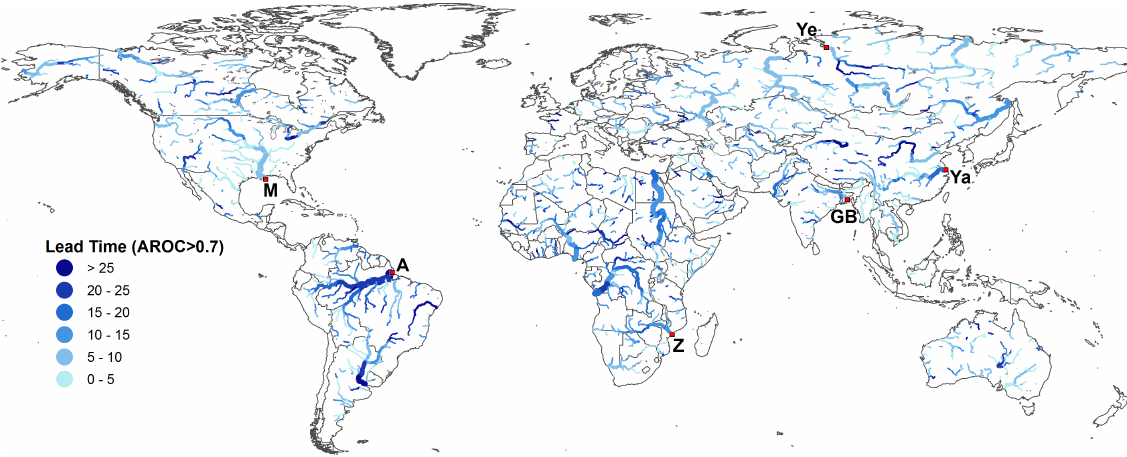
Fig. 8. Forecast lead time, in days, for which ESPs are skillful (AROC >